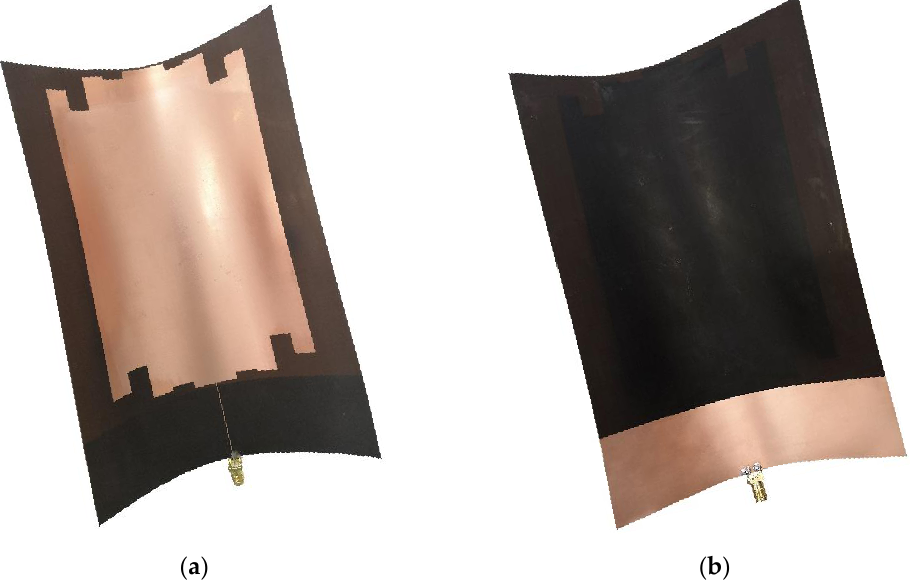
Figure 8. Physical view of the antenna: ( a ) Front side of the antenna; ( b ) Back of the antenna;.